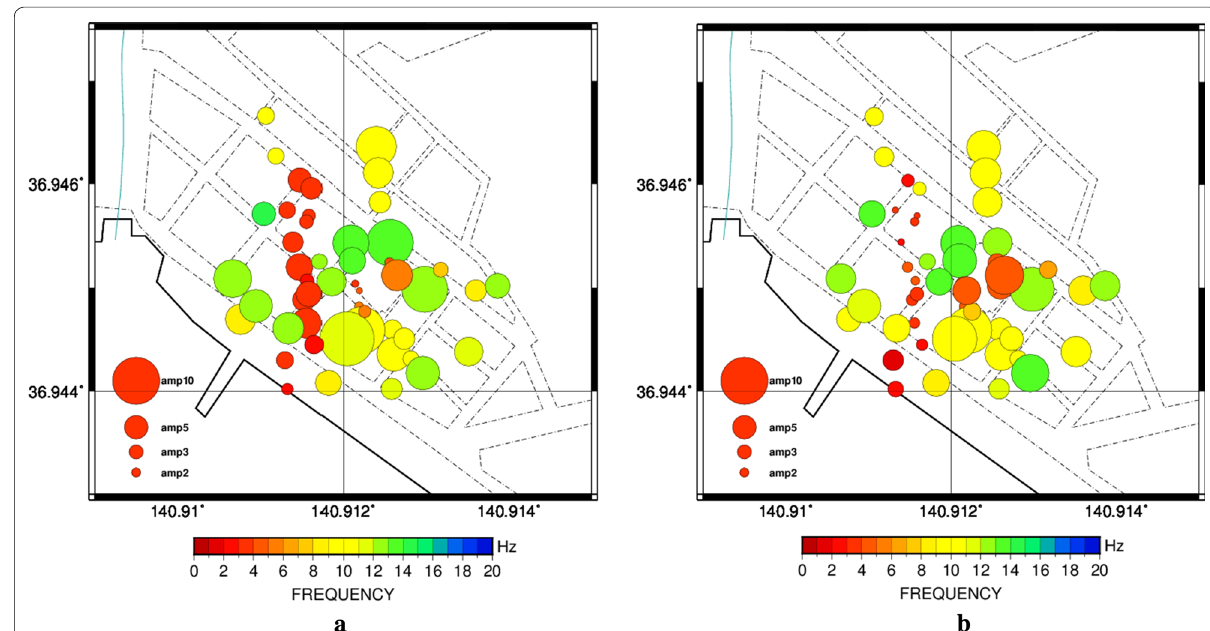
Fig. 8 Distribution of the peak frequency and the peak amplitude of a NS/UD and b EW/UD of MHVRs for points in Fig. 3. The colors indicate the peak frequency, and the size of the circles indicates the amplitude at the peak frequency